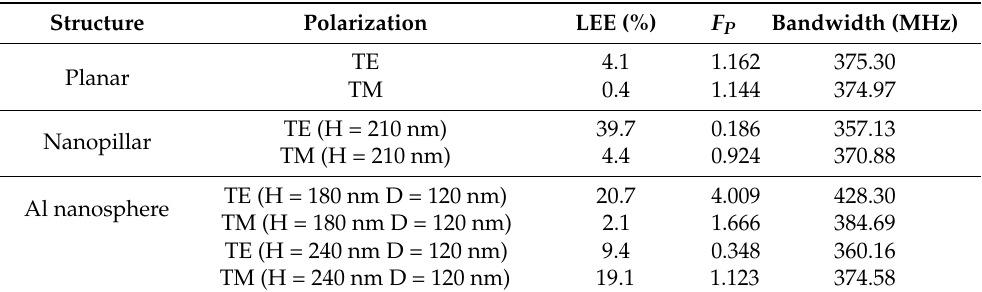
Table 1. Comparison on different polarized LEE, Purcell factor and modulation bandwidth for planar, nanopillar and Al nanosphere structure DUV-LEDs.